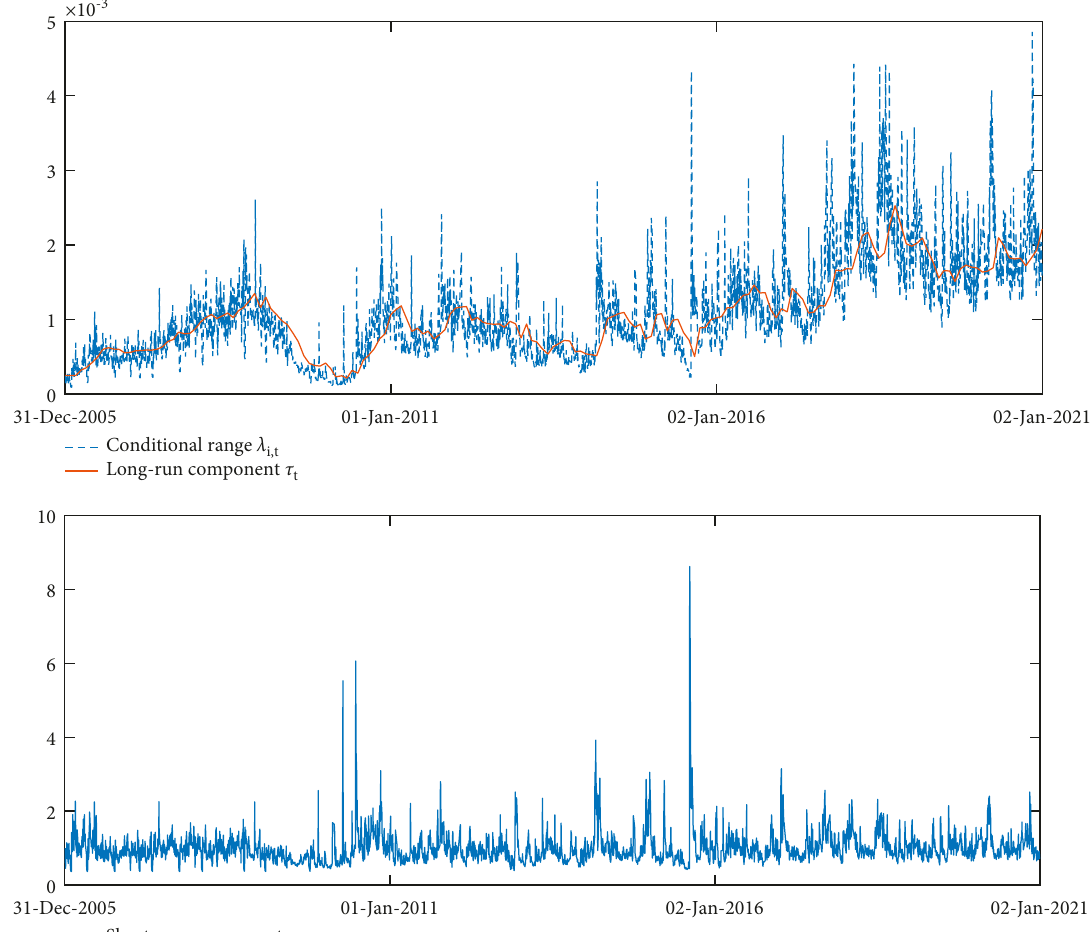
Figure 2: Conditional range ( λ